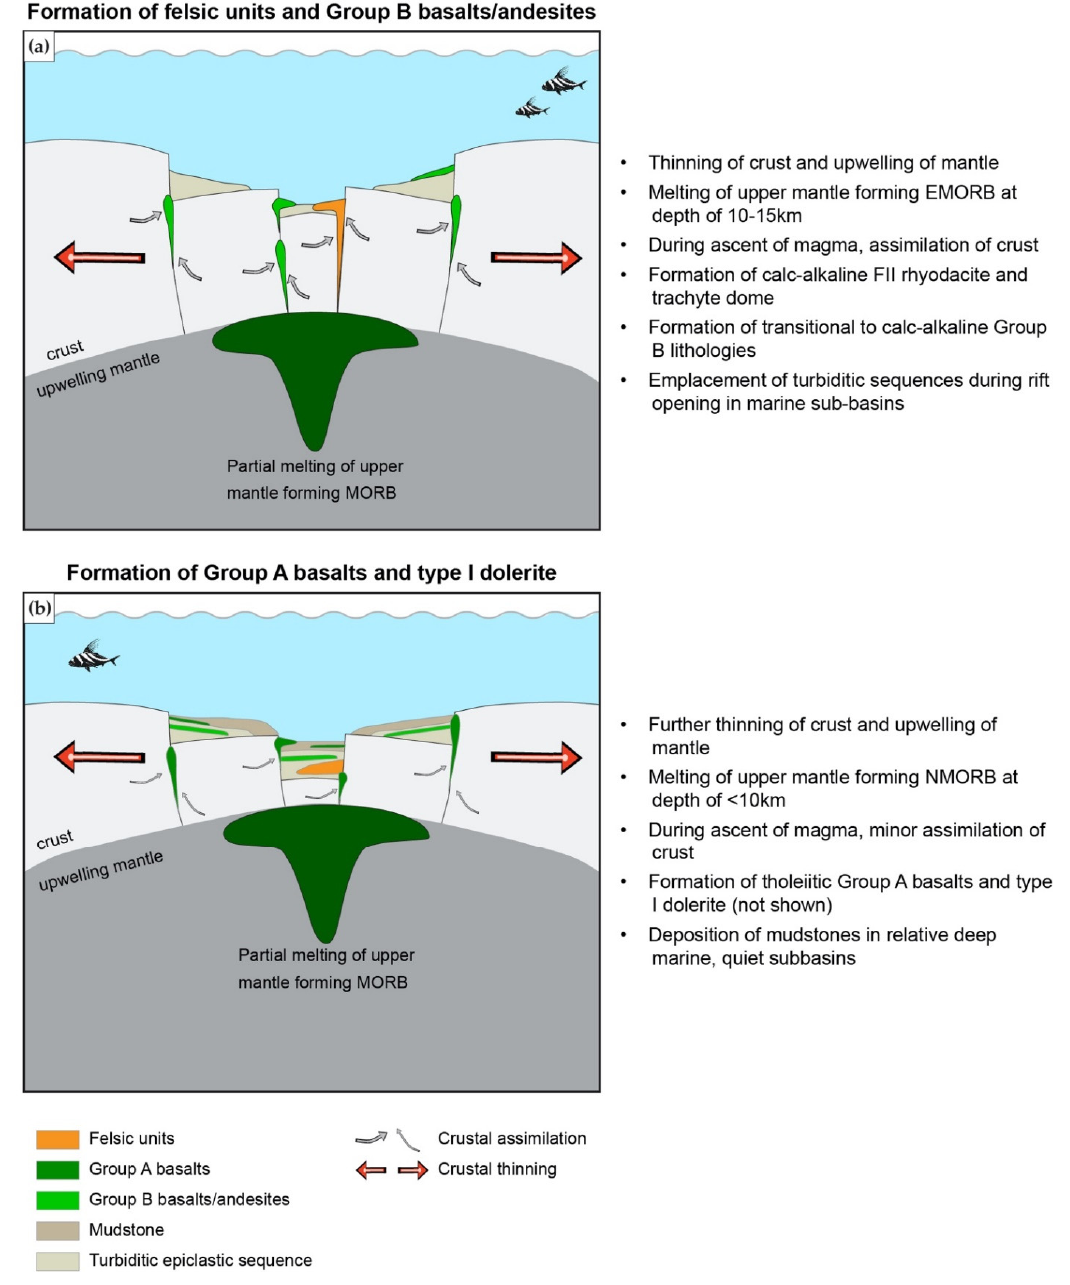
Figure 23. Simplified genesis of the A6 Anomaly in an evolving back-arc basin rift, ( a ) Formation of altered felsic units and Group B mafic rocks due to deep partial melting of upwelling mantle producing EMORB, ( b ) Continuing thinning of back arc rifting resulting in shallower partial melting depth of upwelling mantle which is the source for Group A basalts and type I dykes; sketches not to scale.